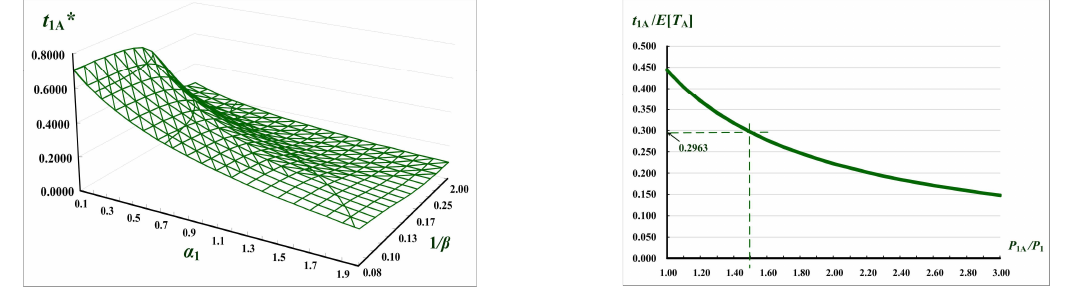
Fig. 12 . Combined effect of differences in expedited Fig. 13 . The influence of variations in expedited ratio rate factor α 1 and mean-time-to-failure 1/ β on t 1A * P 1A / P 1 on machine utilization Fig. 14. exhibits the impact of changes in random scrap rate x on different cost elements in E [ TCU ( t 1A *)]. It specifies that as x increases, product quality cost boosts extensively.